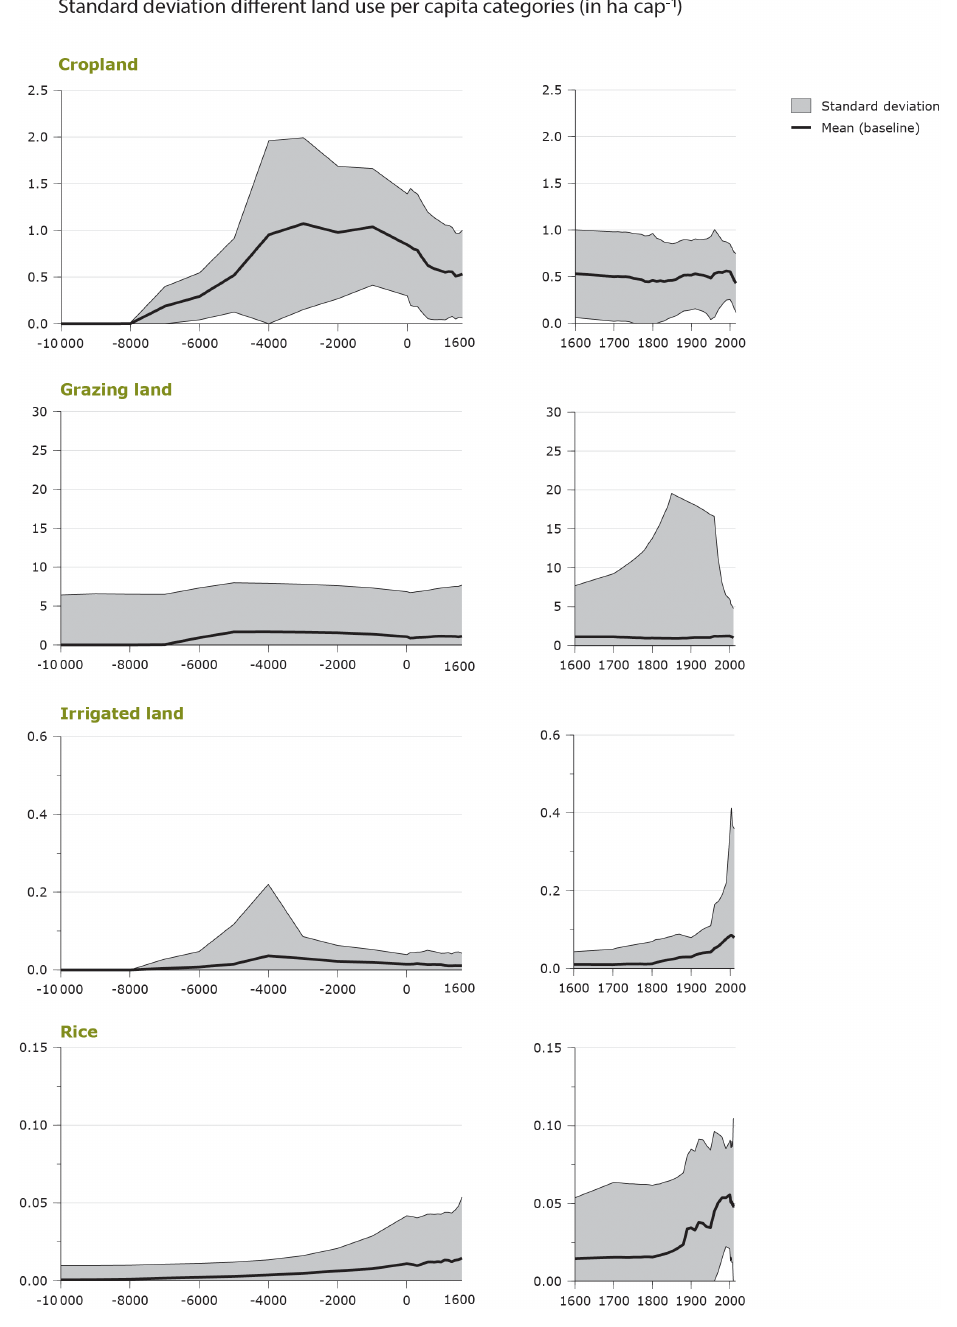
Figure 11. Standard deviation of input data per